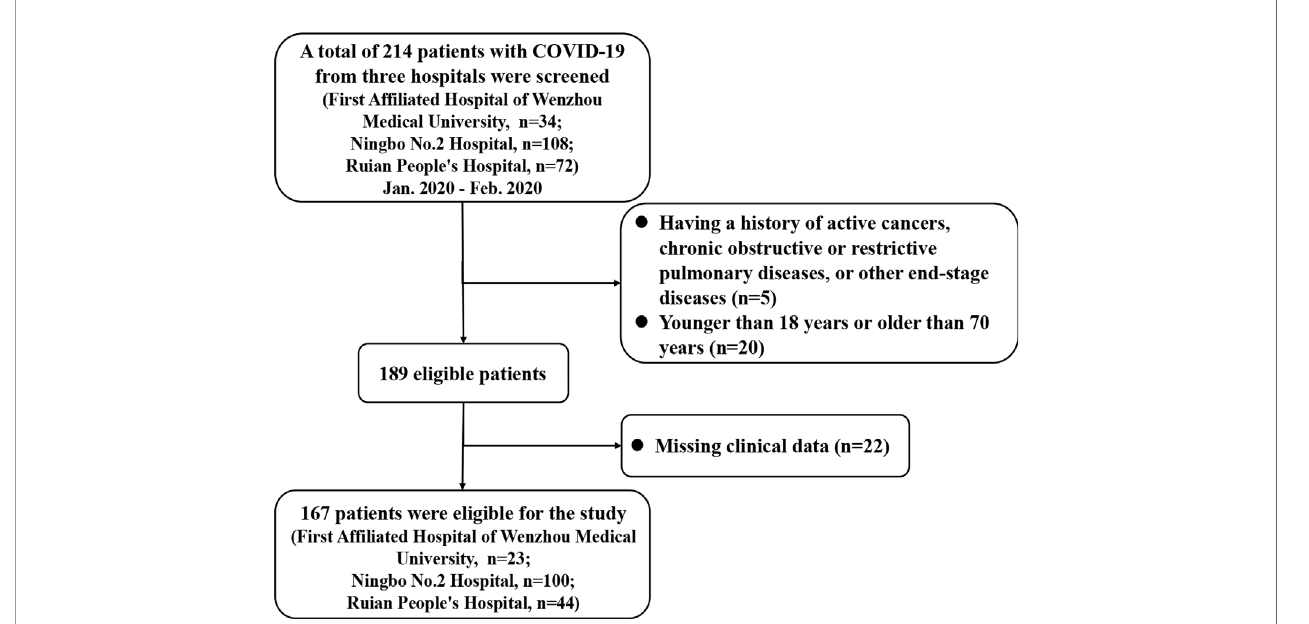
FIGURE 1 | The fl ow chart for the